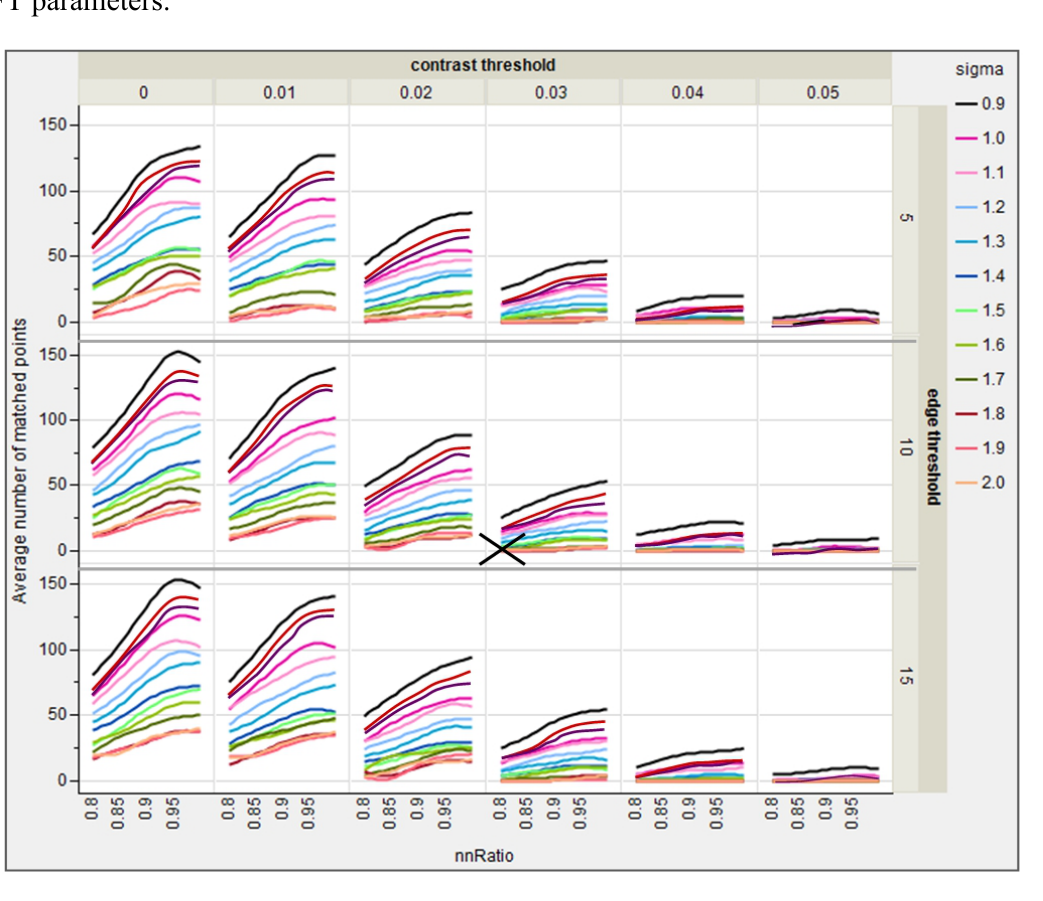
Figure 7. Average number of points matched per single hyperspectral band for different initial image smoothing (sigma) levels, plotted against the nearest-neighbor ratio (nnRatio) for different contrast thresholds and edge thresholds. Graph created for number of scales in each octave (nScales) equal to 3. Black cross indicates results obtained using default SIFT